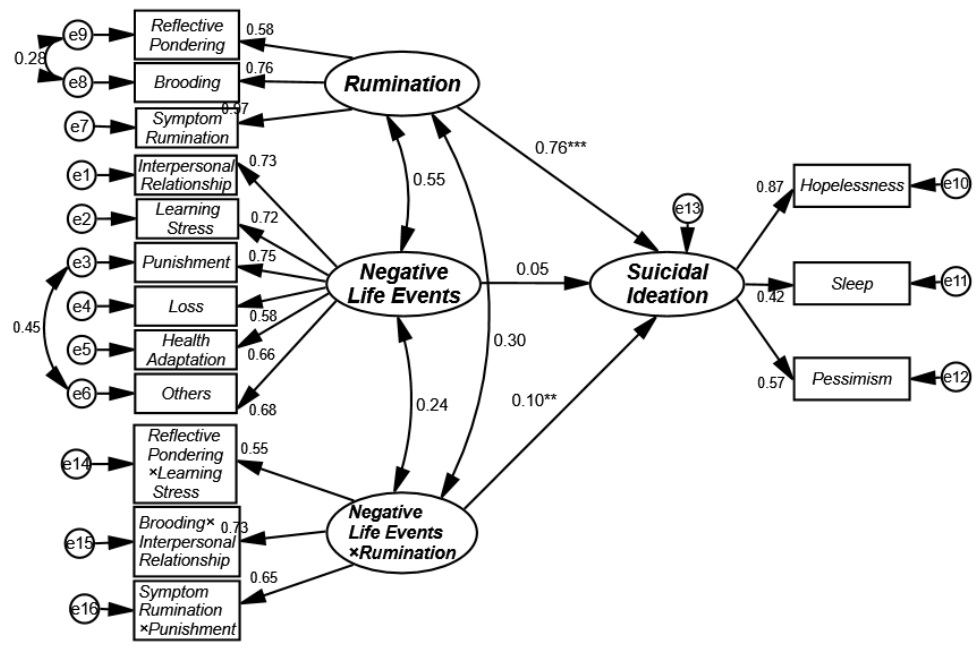
Figure 2. The model of the moderating effect of rumination in the influence of negative life events on suicidal ideation in college students. ** p < 0.01, *** p < 0.001.